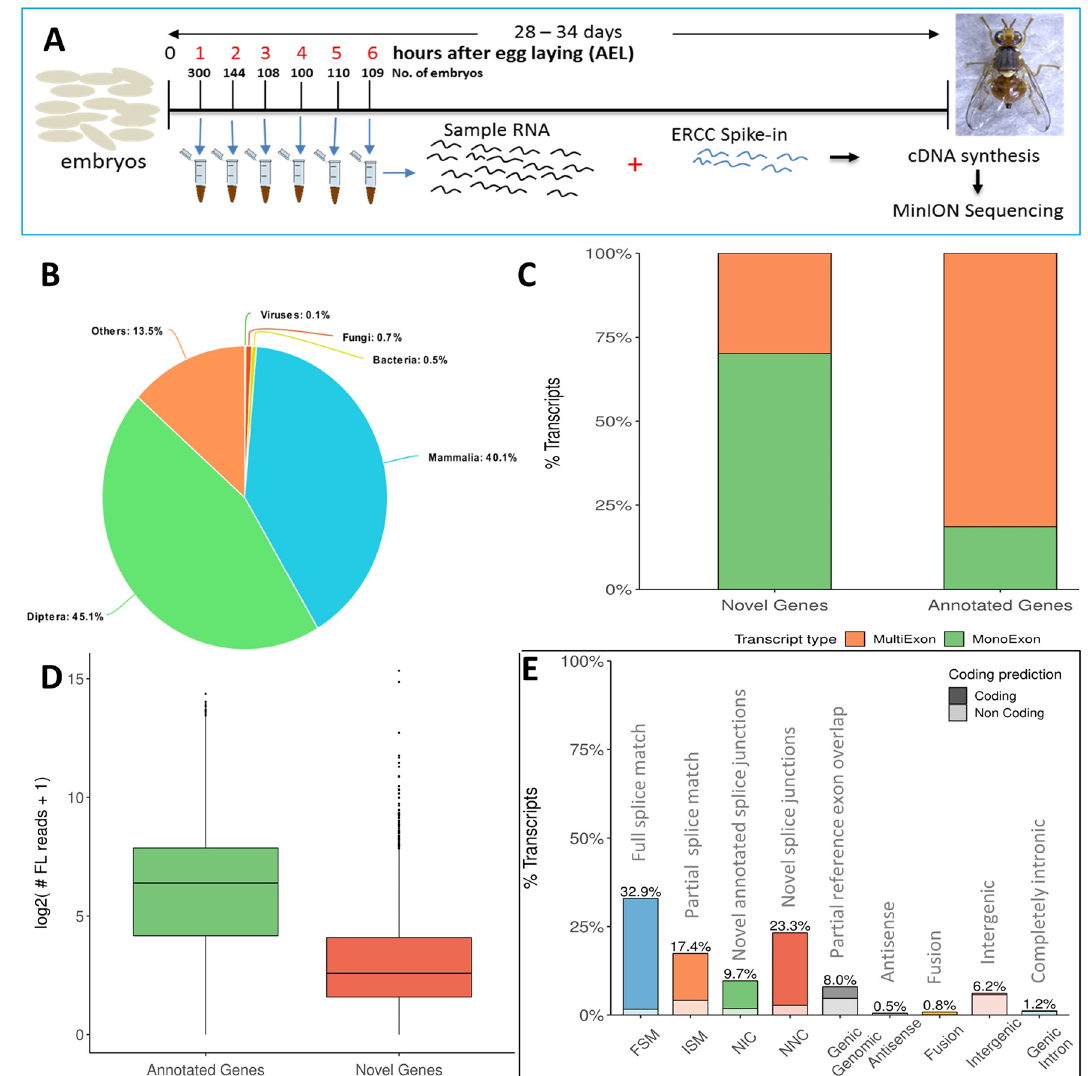
Figure 1. Exploration of the transcriptome assembly. ( A ) Schematic of cDNA library generation and sequencing process. Bactrocera oleae embryos were collected at hourly intervals, counted, pooled, and total RNA extracted using the Trizol method. At cDNA synthesis step, external RNA standards (ERCC) were added to each sample commensurate to the number of embryos that were used. The Smart-Seq2 protocol was used to generate full length cDNA, followed by PCR amplification of the cDNA. The Oxford Nanopore Technologies (ONT) SQK-LSK108 protocol for library preparation was then followed, albeit with some custom changes. The library was then sequenced on the ONT MinION, followed by basecalling using ONT Albacore basecaller. After egg laying (AEL) ( B ) Distribution of top Blastp hits of transcripts in the B. oleae de novo long-read transcriptome assembly to UniProt Swiss-Prot database. ( C ) Distribution of mono and multi-exon transcripts among previously known genes and novel genes ( D ) Gene expression levels of previous annotated genes and novel genes using long-read counts. ( E ) Distribution of de novo transcriptome assembly transcripts among different structural categories when compared to NCBI predicted gene models. ( C – E ) Generated using SQANTI 21 . FSM full splice match, ISM incomplete splice match, NIC novel in catalogue, NNC novel not in catalogue (see Table S1 for